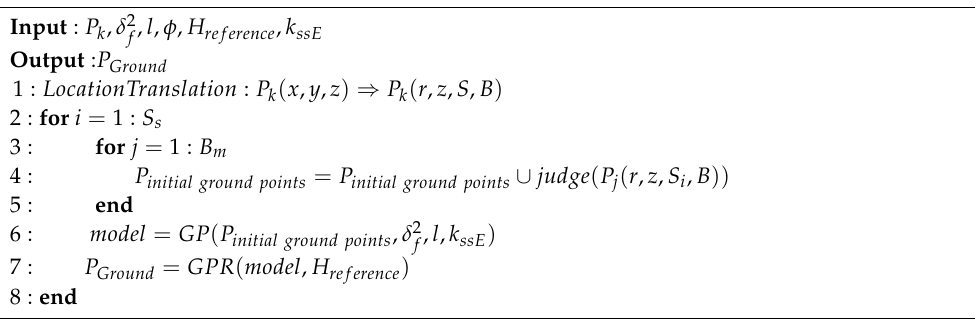
Algorithm 1 Ground segmentation based on Gaussian process regression with sparse